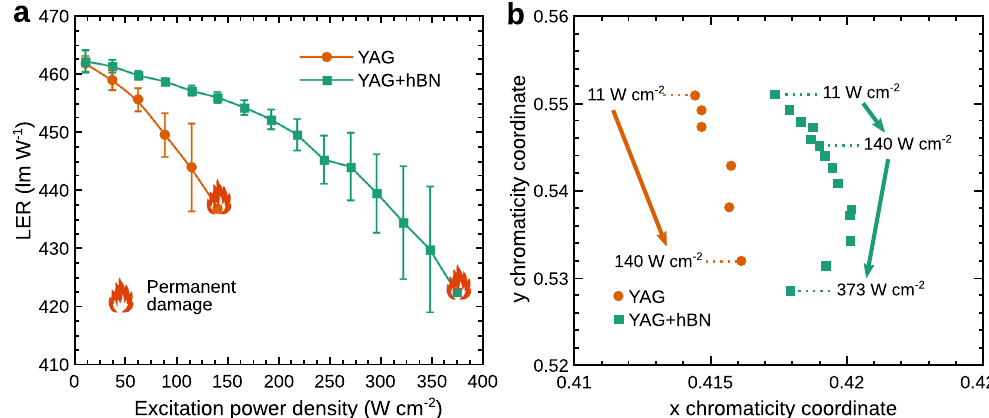
Figure 7. Spectral parameters of 15 wt% YAG and 15 wt% YAG + 30 wt% hBN silicone converters for different excitation power densities. ( a ) The dependence of LER on the excitation power density. ( b ) The xy chromaticity coordinates for different excitation power